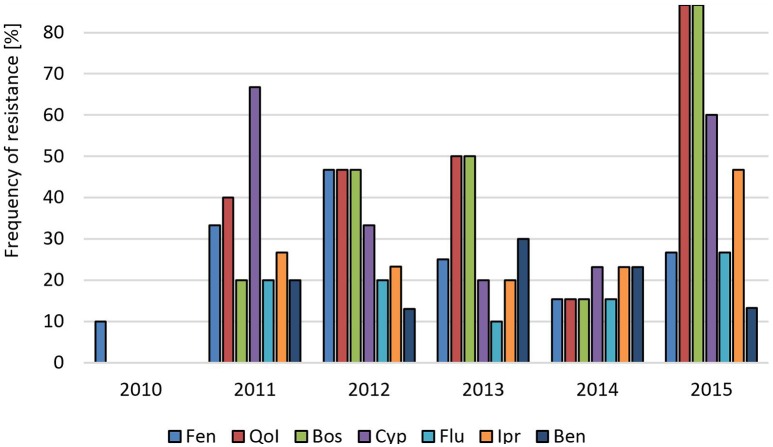
Changes in fungicide resistance frequencies in B. cinerea isolates over 6 years in a sweet cherry orchard in Northern Germany. Abbreviations are as in Figure 1.